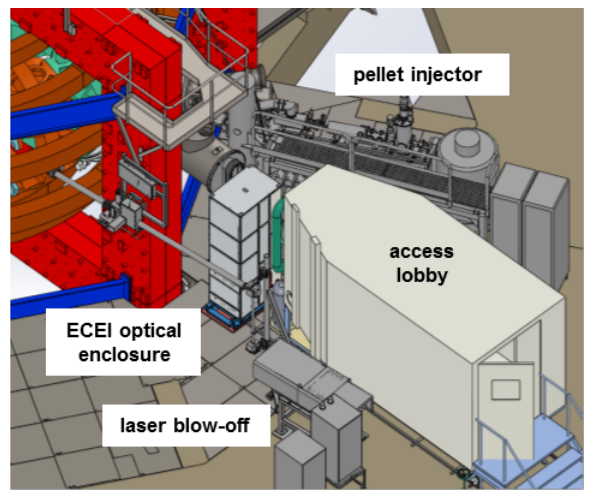
Fig. 2. View of WEST Q5A sector with the main elements showing the ECEI optical enclose, the access lobby and the pellet injector. The laser blow-off system is connected to the neighbouring sector . The X-ray imaging crystal spectrometer (not shown) is now installed on the right side of the pellet